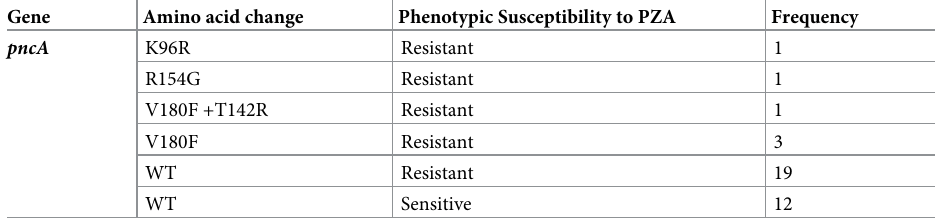
Table 1. Frequencies of mutations in different regions in the pnc A gene.